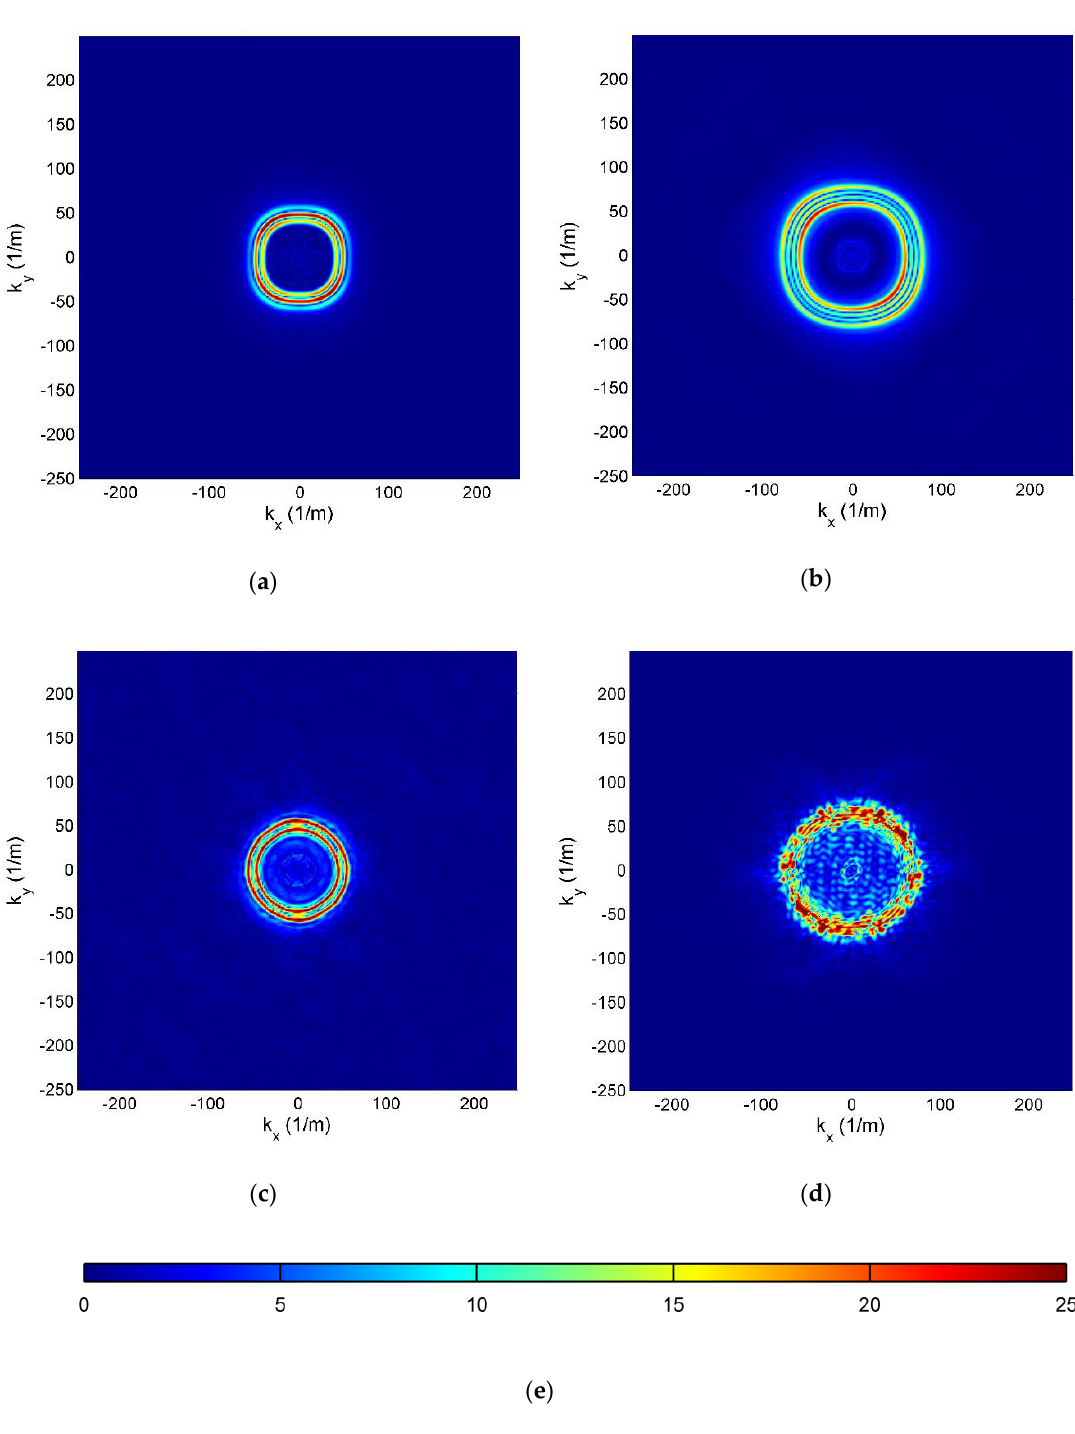
Figure 9. Wavefield patterns in wavenumber domain for: ( a ) CFRP; ( b ) GFRP; ( c ); SFRP ( d ); HCSP specimen; ( e ) Color scale.